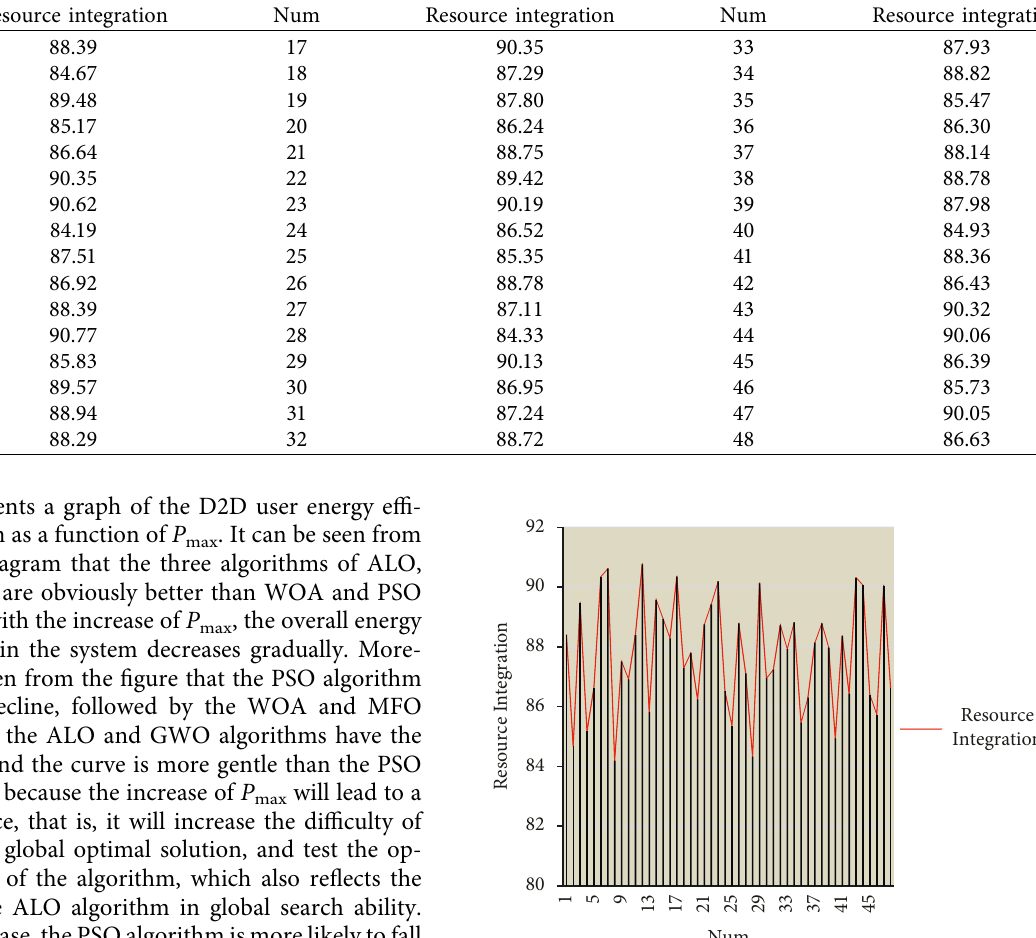
Table 1: Evaluation of resource integration effect of AI English teaching resource information intelligent integration system based on multi- agent writing.